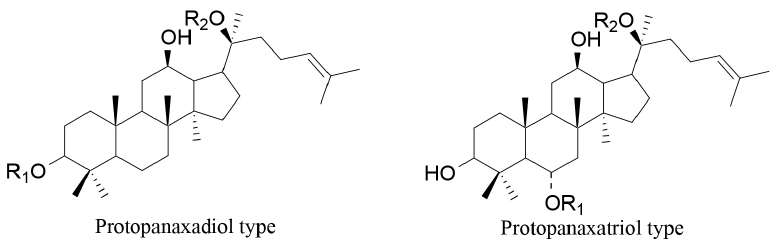
Figure 6. Protopanaxadiol and protopanaxatriol type saponins [89,92].